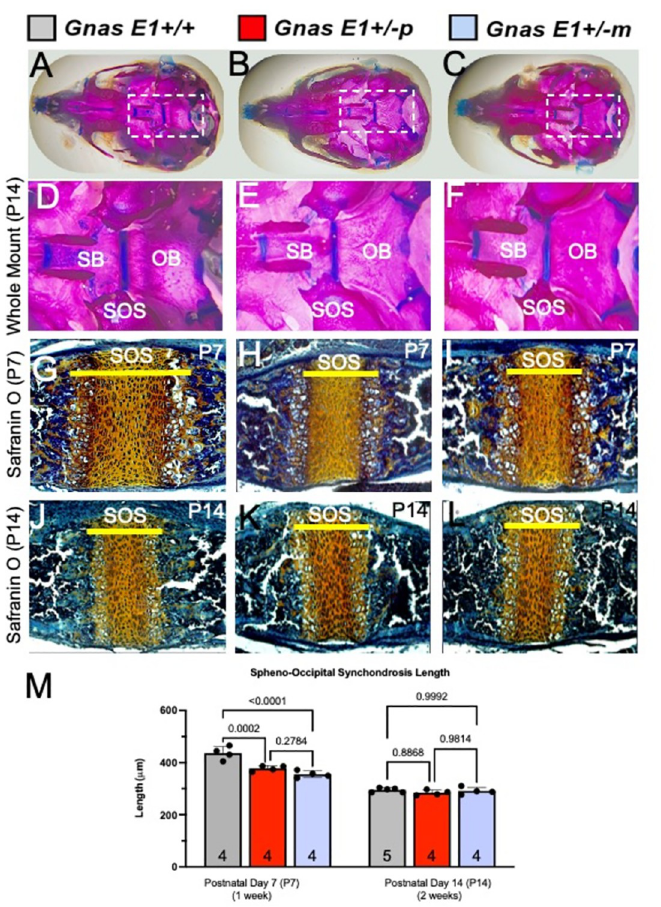
Fig 5. Gnas E1+/- mice display a significant reduction in spheno-occipital synchondrosis length. Representative low power (A-C) and higher power (D-F) whole mount images of the cranial base of 2-week-old (P14) (A, D) WT, (B, E) Gnas E1+/-p and (C, F) Gnas E1+/-m mice. Dashed rectangle in A-C is shown as larger image within D-F and highlights spheno-occipital synchondrosis. (G-I) Representative images of the cranial base of 1-week-old (P7) (G) WT, (H) Gnas E1+/-p and (I) Gnas E1+/-m mice stained with safranin O and fast green. (J-L) Representative images of the cranial base of 1-week-old (P7) (J) WT, (K) Gnas E1+/-p and (L) Gnas E1+/-m mice stained with safranin O and fast green. (M) Measurement of total SOS length (yellow line) among WT, Gnas E1+/-p and Gnas E1+/-m mice at both one and two weeks of age. Sample size per genotype per experiment is listed on each graph. All statistical tests completed using a two-way ANOVA with post-hoc Tukey test for multiple comparisons, and p -values are displayed for each comparison. For orientation, the sphenoid bone (SB) and occipital bone (OB) are identified on panels D-F for appropriate localization in relation to the